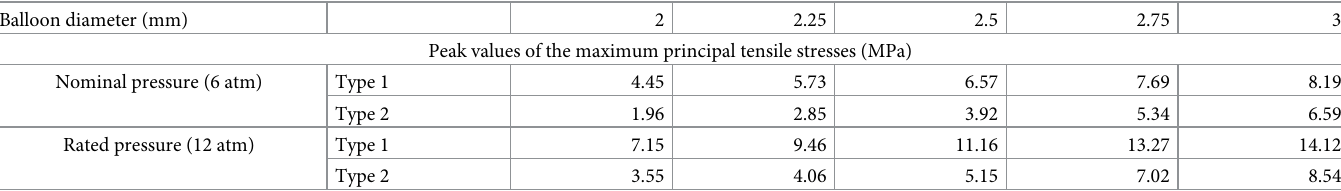
Table 4. Peak values of the maximum principal tensile stresses in the model of artery adjacent to the calcification. Balloon diameter (mm)